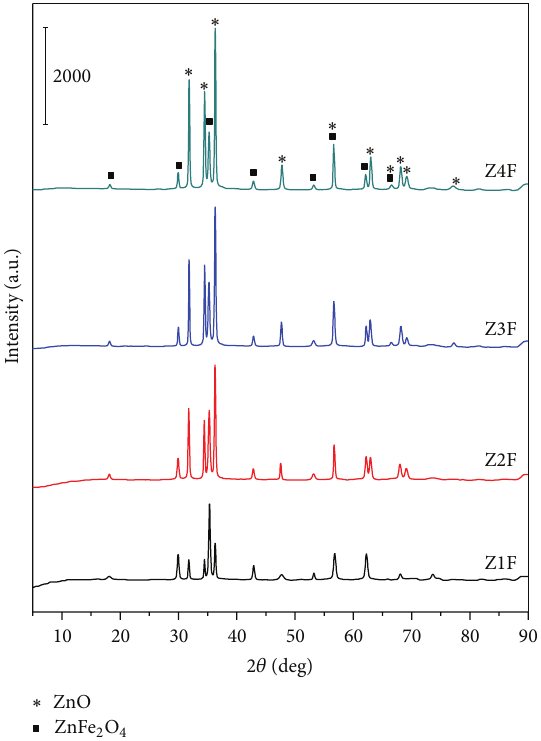
Figure 2: PXRD patterns of calcined Zn-Fe-LDH nanostructure. crystal plane it is 43.3 nm [3, 10, 11] as estimated using Scherrer’s